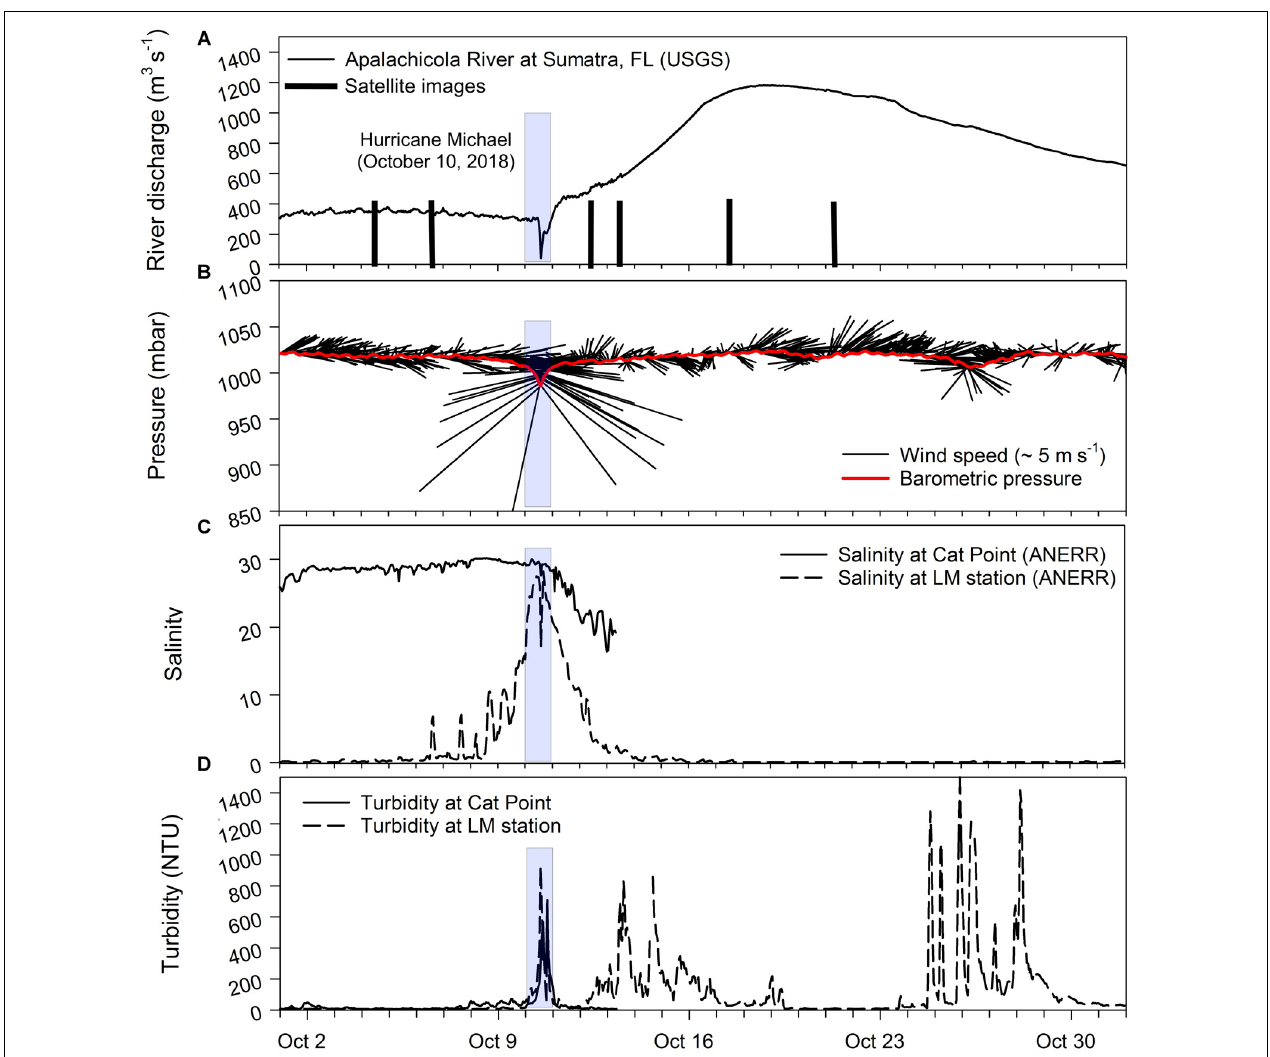
FIGURE 2 | Time-series measurements during October 2018. (A) Apalachicola River discharge (m 3 s − 1 ) with vertical black bars denoting availability of mostly cloud free MODIS imagery on 4, 6, 12, 13, 17, and 21, October 2018. (B) air pressure and wind vectors (wind speed and direction from true north) with light blue bar on 10 October 2018 representing the Hurricane Michael landfall, (C) salinity at Cat Point (CP; solid line) and LM station (LM; dashed line), and (D) turbidity at CP and LM stations for the period 1–31 October